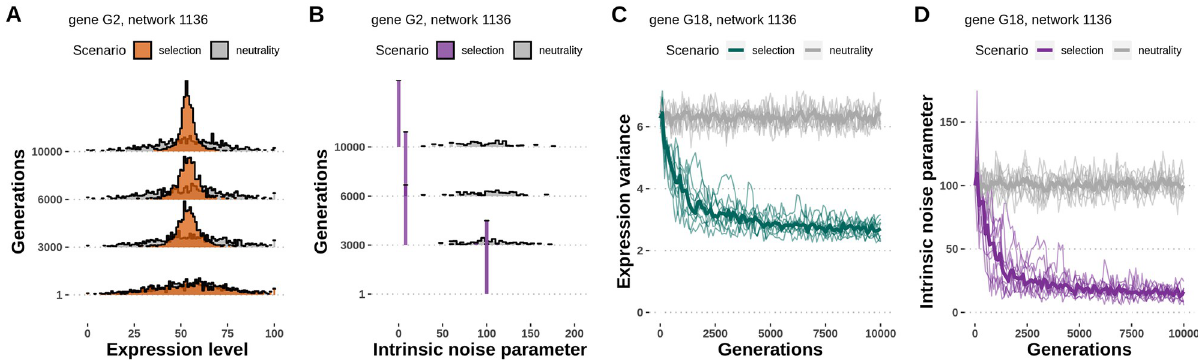
Fig 3. Gene-specific expression noise evolves in a model with selection. A —The distribution of expression levels of an example gene throughout evolution in populations evolved under stabilizing selection on gene expression level and under neutrality. The variance of gene expression level is reduced under selection, but not under neutrality. B —The distribution of intrinsic noise parameters of an example gene throughout evolution in populations evolved under selection and under neutrality. The median intrinsic noise parameter skews to lower values under stabilizing selection, but not under neutrality. C, D —Replicates of the simulations with the same input network and parameters. Replicates have different dynamics, but reach similar outcomes in terms of expression variance (C) and median intrinsic noise parameter (D) in the evolved populations. The evolution of each network topology sample was replicated 10 times under selection and 10 times under